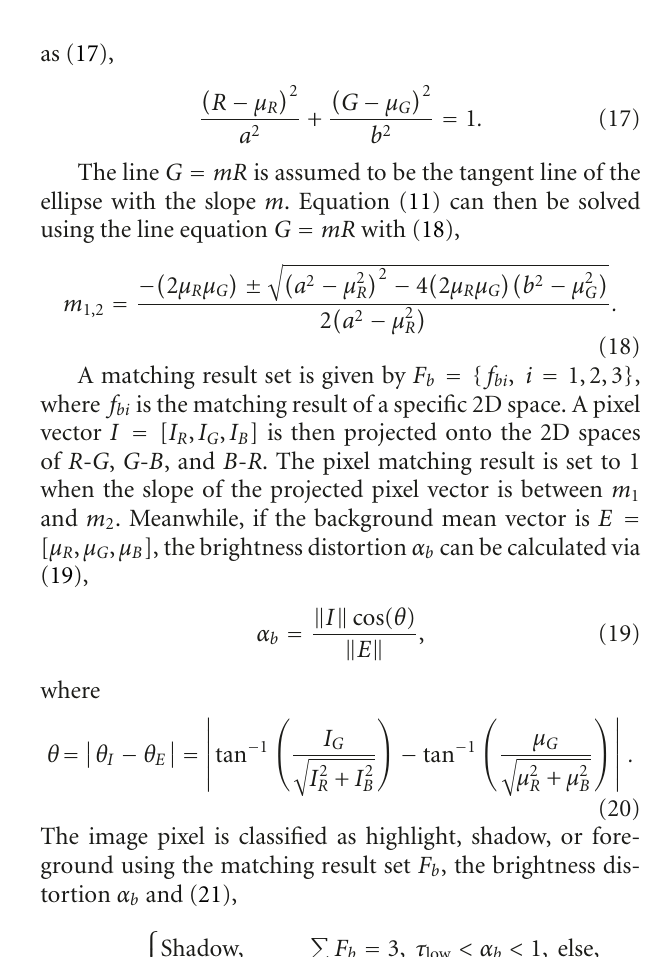
Figure 5: 2D projection of the 3D cone model from RGB space onto the RG